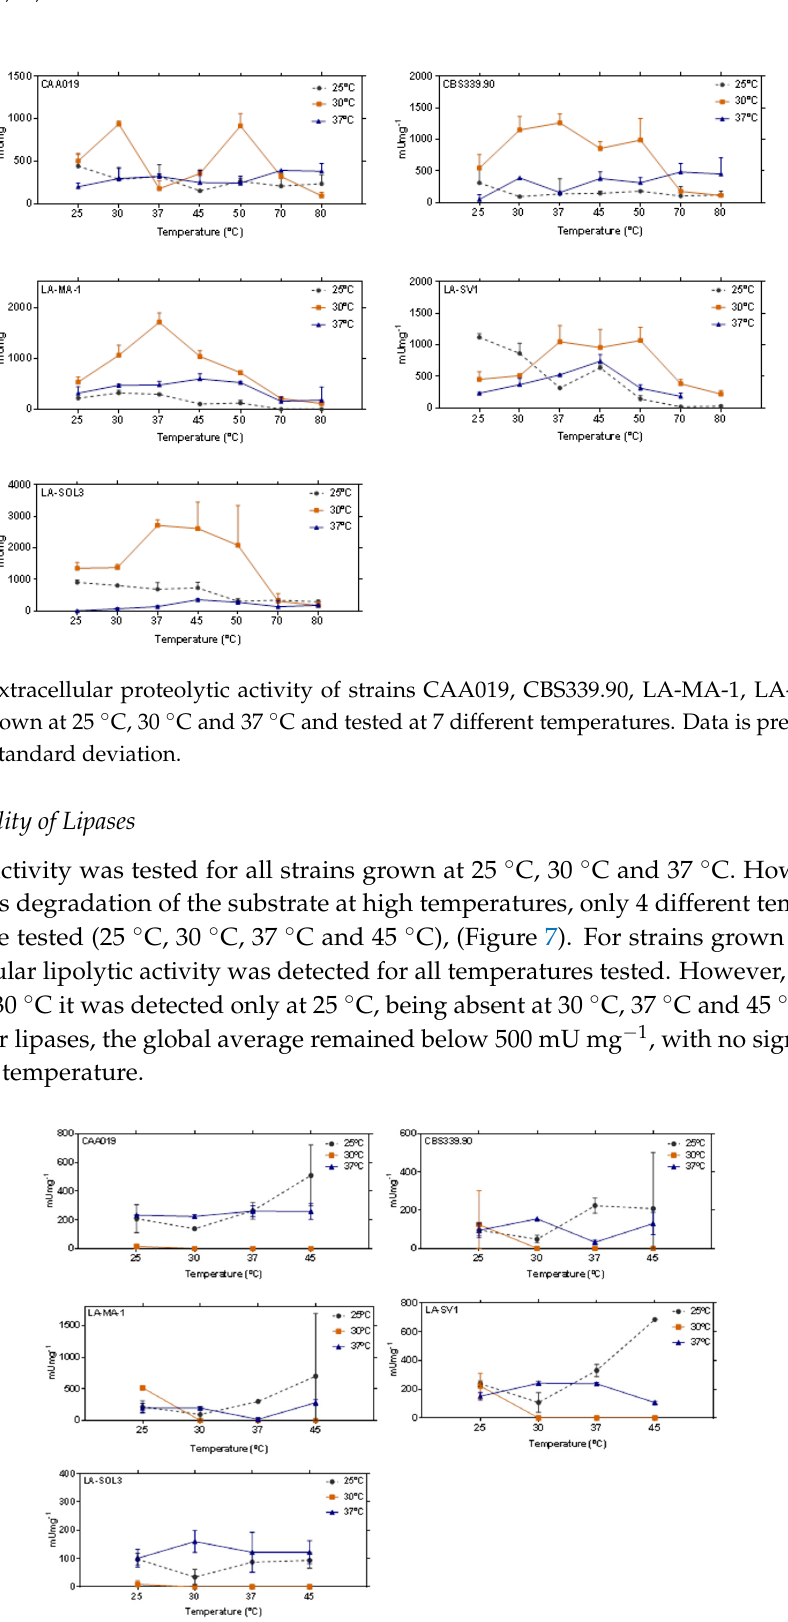
Figure 7. Extracellular lipolytic activity of CAA019, CBS339.90, LA-MA-1, LA-SV1 and LA-SOL3 grown at 25 °C, 30 °C and 37 °C and tested at 4 different temperatures. Data is presented as average ± standard deviation.